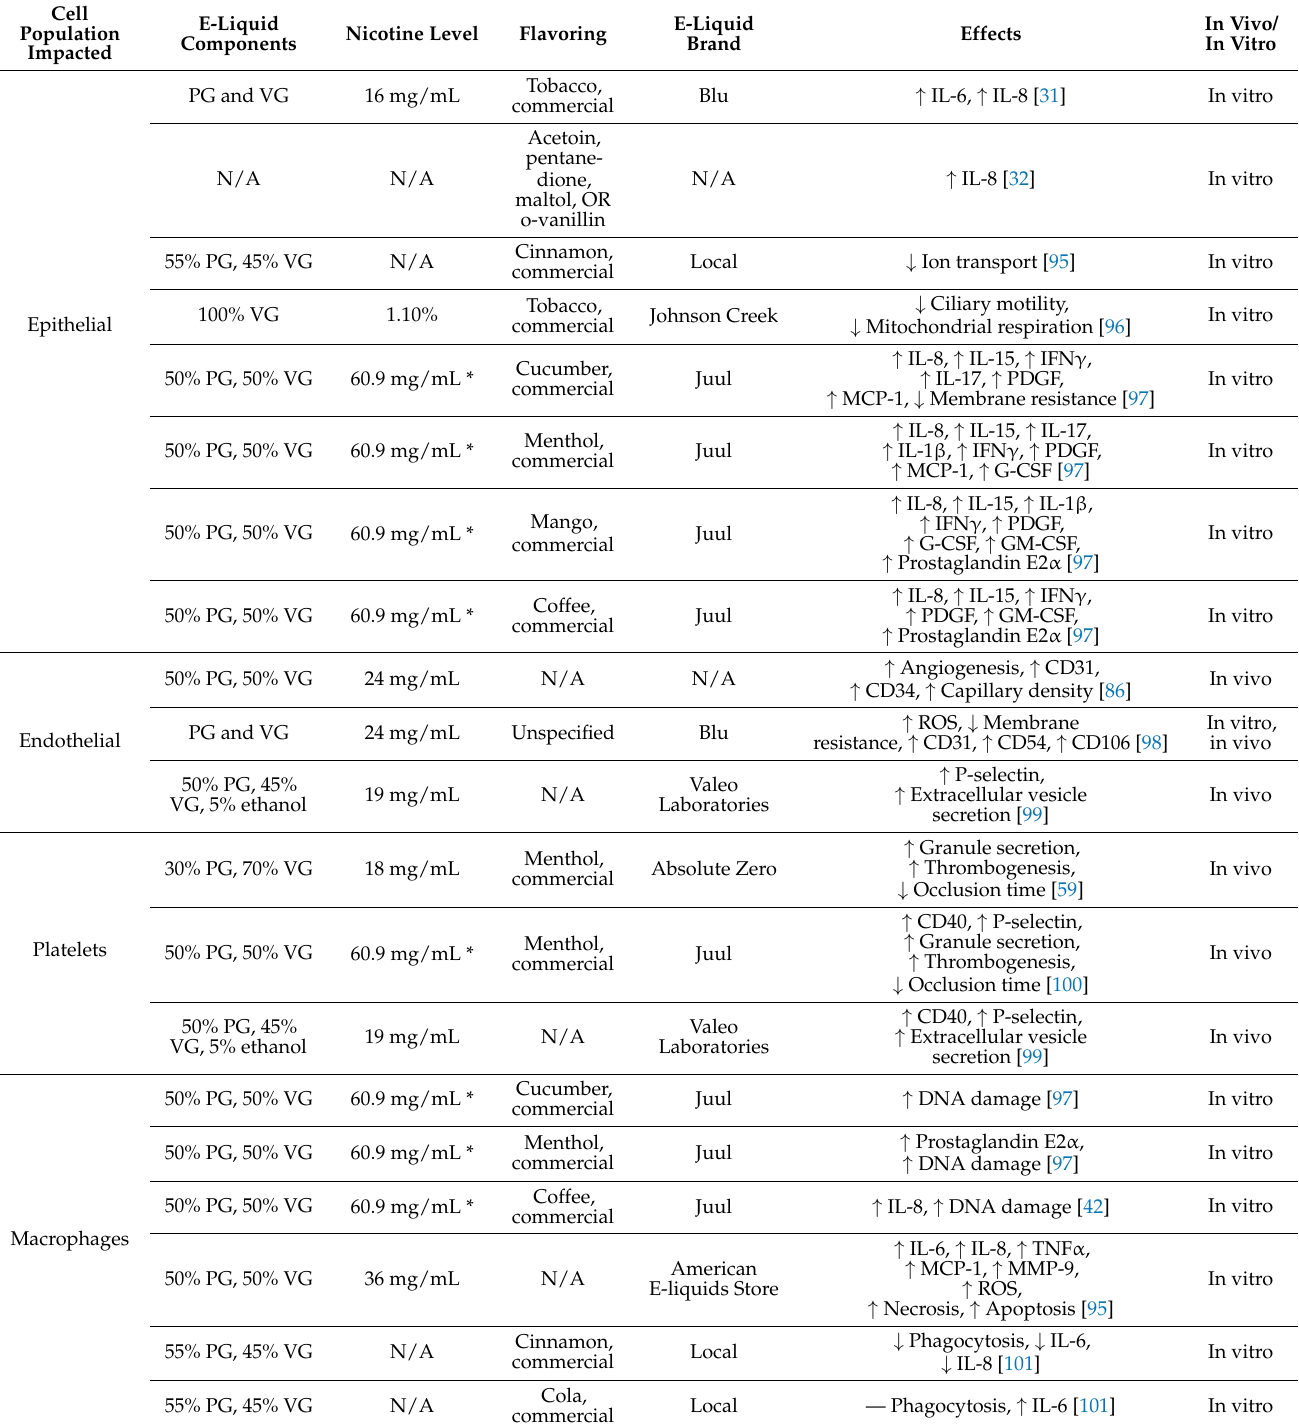
Table 2. Effects of varying device and e-liquid formulations on phenotype for selected cell populations. * indicates nicotine salt e-liquid. ↑ indicates increase; ↓ indicates decrease; — indicates no change. Abbreviations listed in footer 1